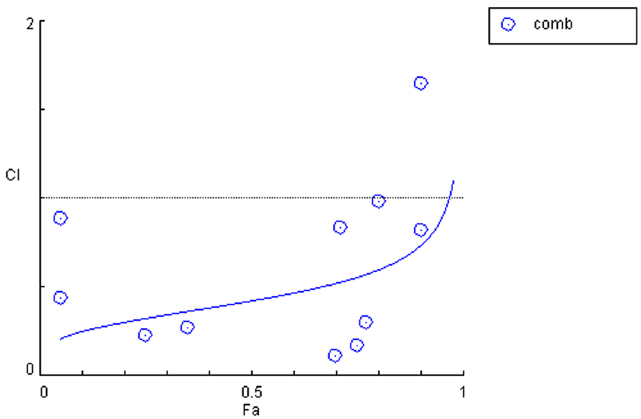
Figure 2. Combination index plot of vitamin C combined with cimetidine with serial two-fold dilutions at a constant ratio (1:1) in the MCF7 human cell line. Values of the CI < 1 reflect synergistic interactions.